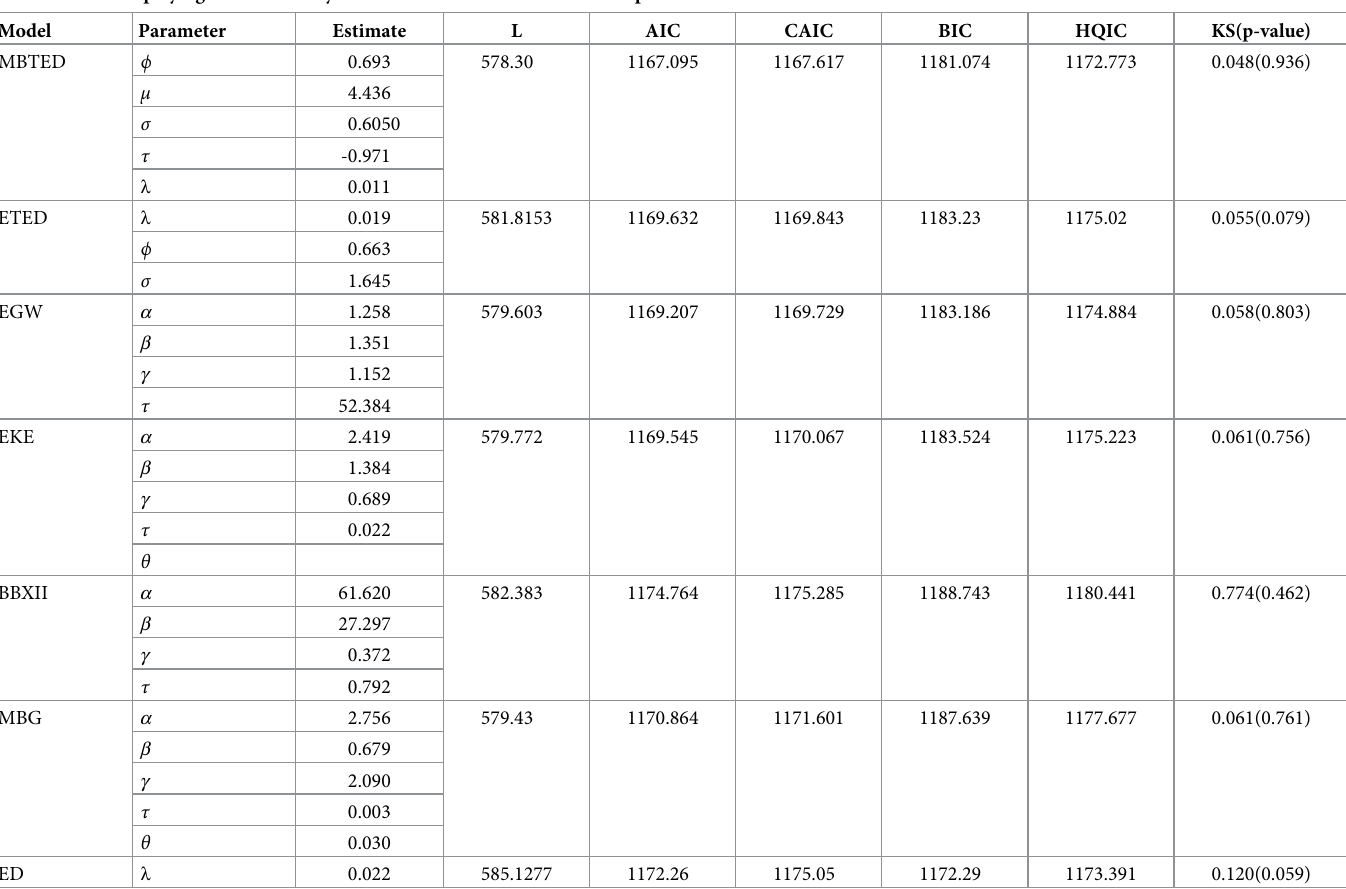
Table 5. Table displaying results of analysis of survival times of breast cancer patients.